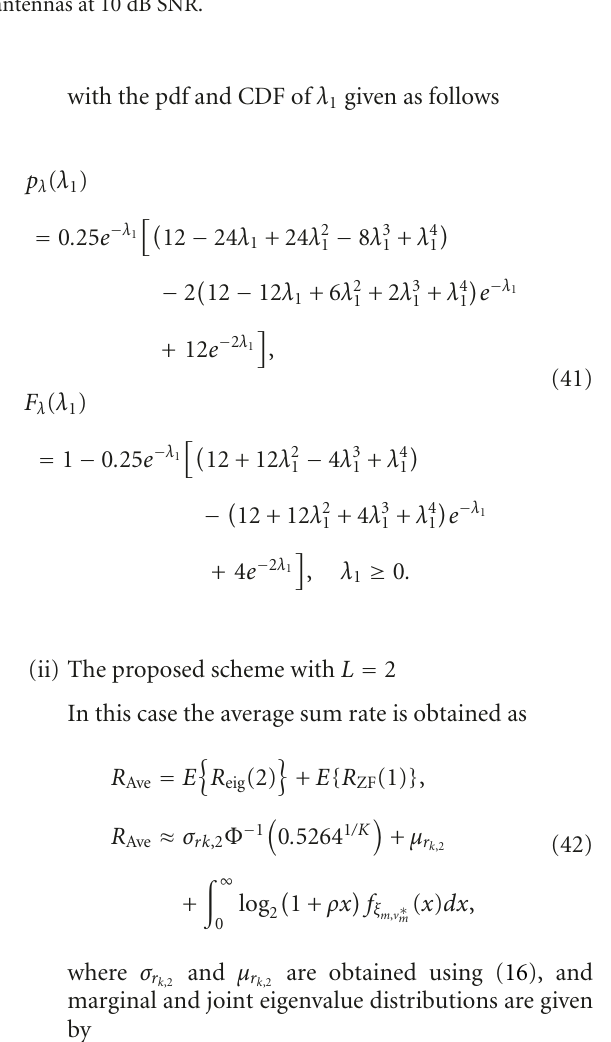
Figure 2: Sum rate of the proposed scheme compared to a number of multiuser MIMO techniques for M = 2 Tx and N = 2 Rx antennas at 10 dB